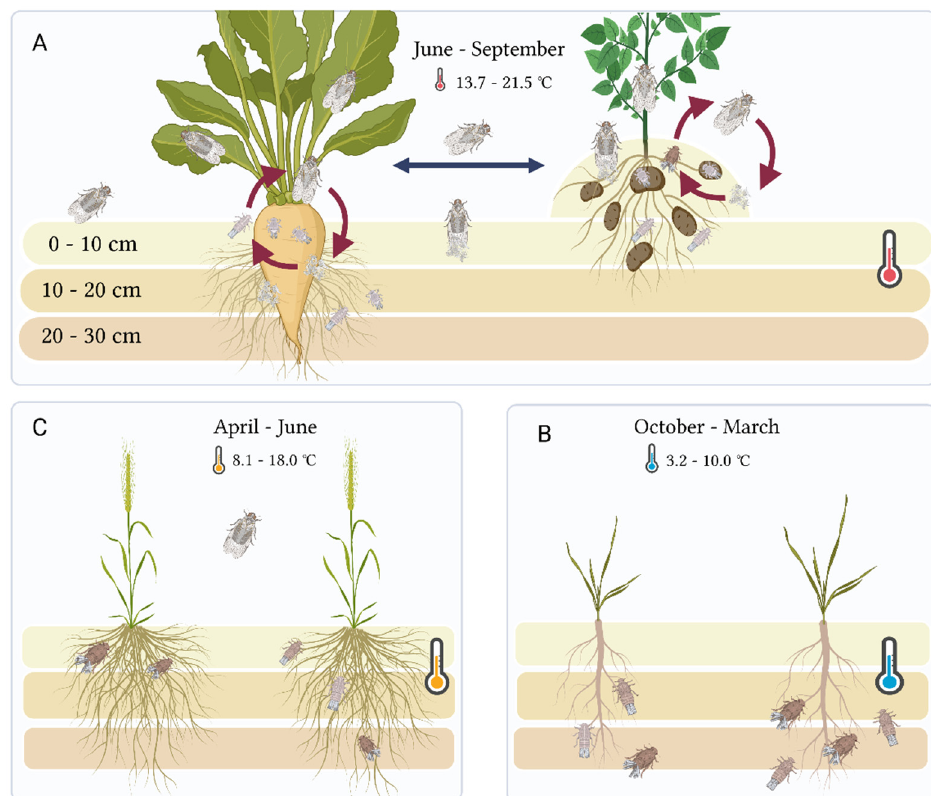
Figure 6. The life cycle of P. leporinus with two different host plants, including data [6]. ( A ) P. leporinus adults lay eggs, which give rise to nymphs, on sugar beet and potato plants between June and September. Under favorable conditions, a second generation of adults develops in the summer, depicted by red arrows. The blue arrow demonstrates the ability of adults to move between host plants. ( B ) Nymph distribution and temperature-dependent movement between October and March. After harvesting, the subsequent crop is usually winter wheat. ( C ) Nymph distribution and temperature- dependent movement between April and June. Thermometer symbols indicate minimum and maximum